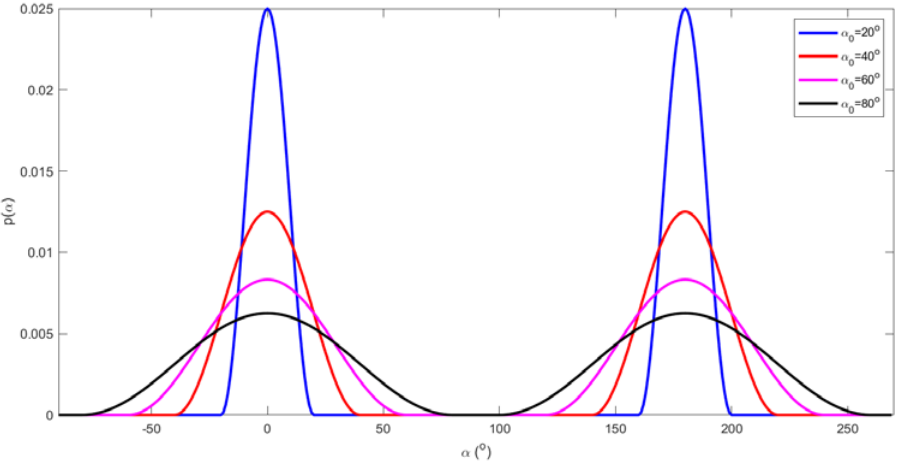
Figure 7. Bimodal raised cosine distribution for several values of the shape parameter α 0